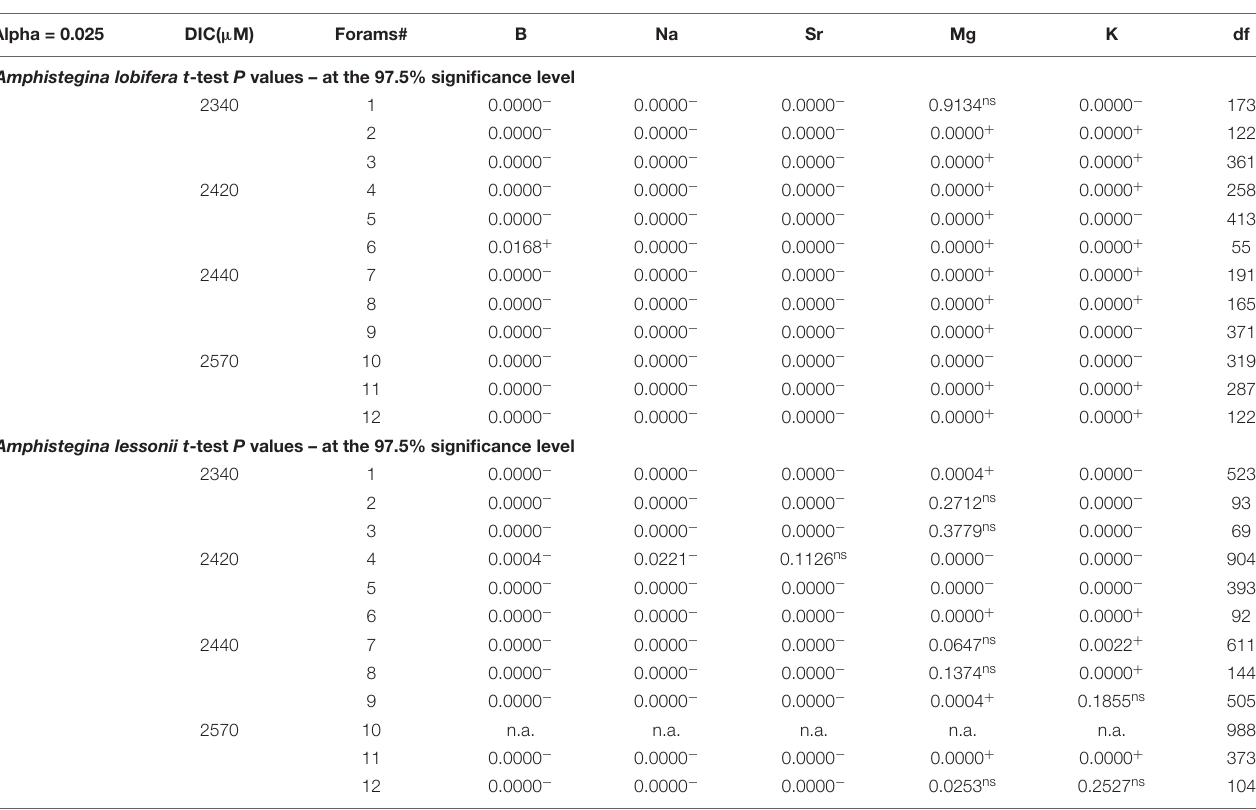
TABLE 2 | Two sample t -test P values (using matlab test2